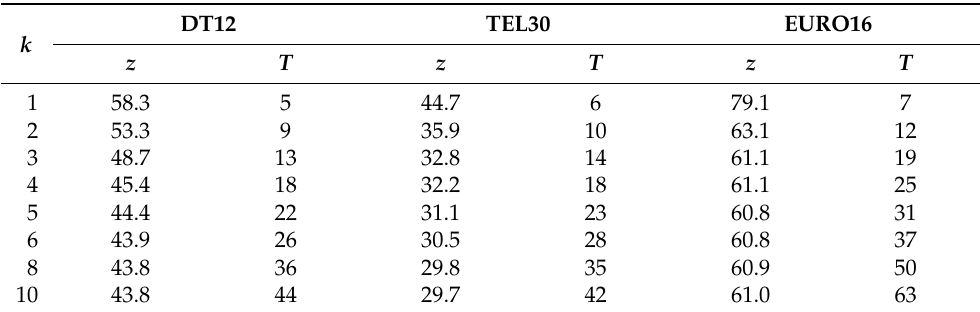
Table 4. An average value of objective function ( z ) and algorithm processing times ( T ) for different number of candidate paths ( k ); T in seconds.